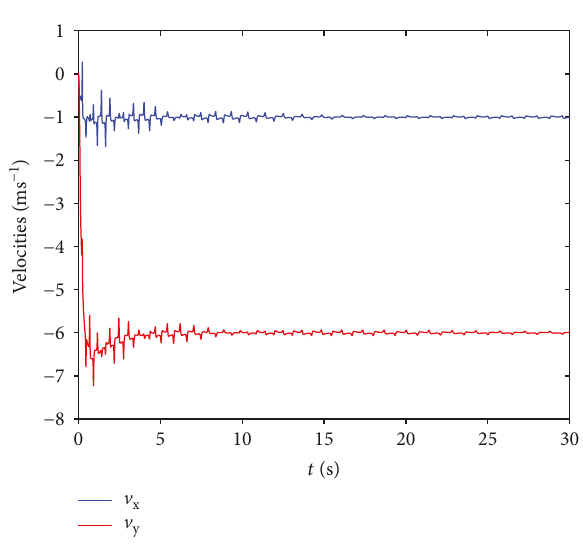
Figure 4: Velocity tracking (line-path